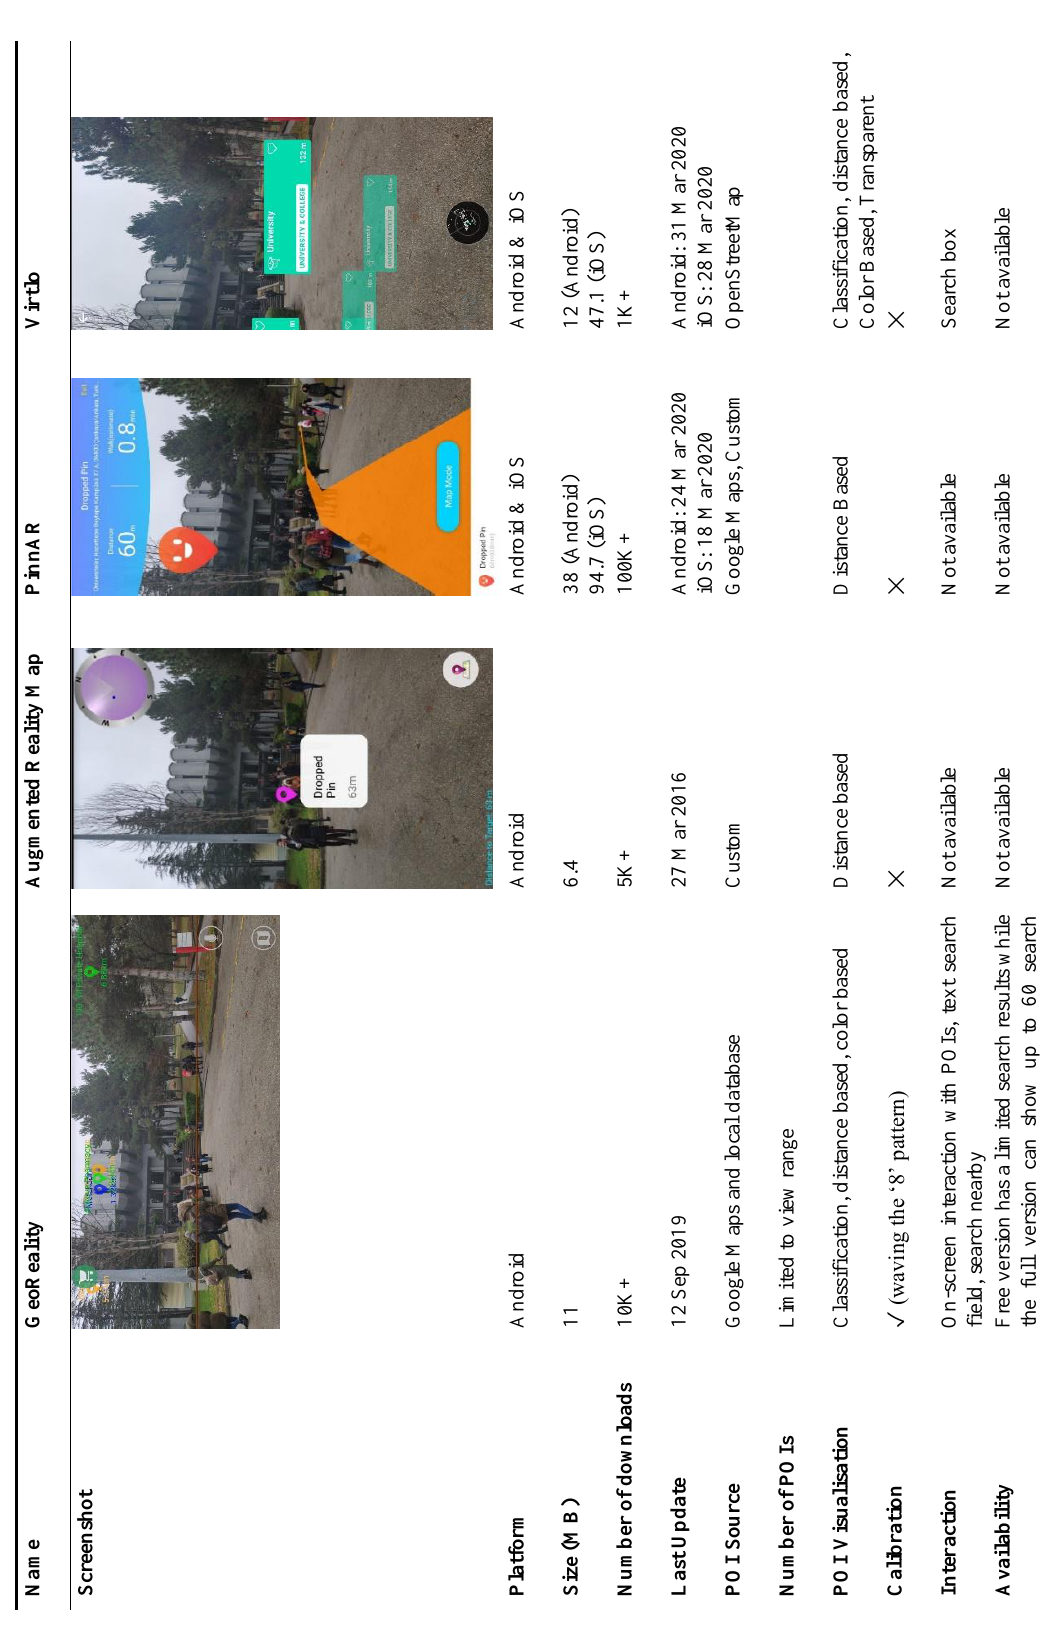
Table 1. Comparison of different AR-based mobile